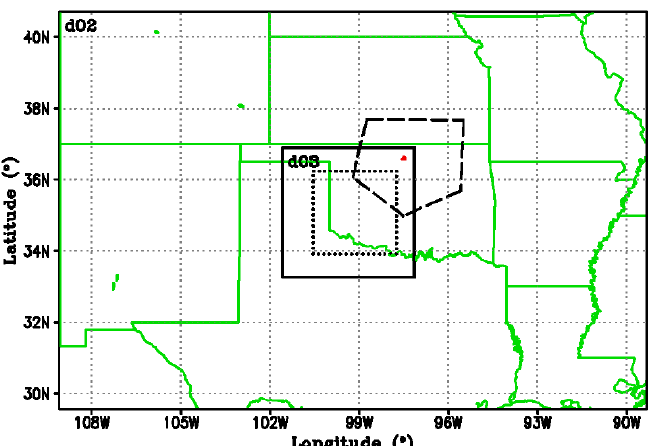
Figure 1. The middle and innermost weather research and forecasting (WRF) domains of the simulation, denoted by d02 and d03, respectively, and enclosed by the solid rectangles. In addition, shown is the largest analysis subdomain with a size of 256 km, outlined by the dotted rectangle. The dashed polygon is the domain of Department of Energy (DOE) atmospheric radiation measurement (ARM) sounding array. The central facility is denoted by the red triangle.